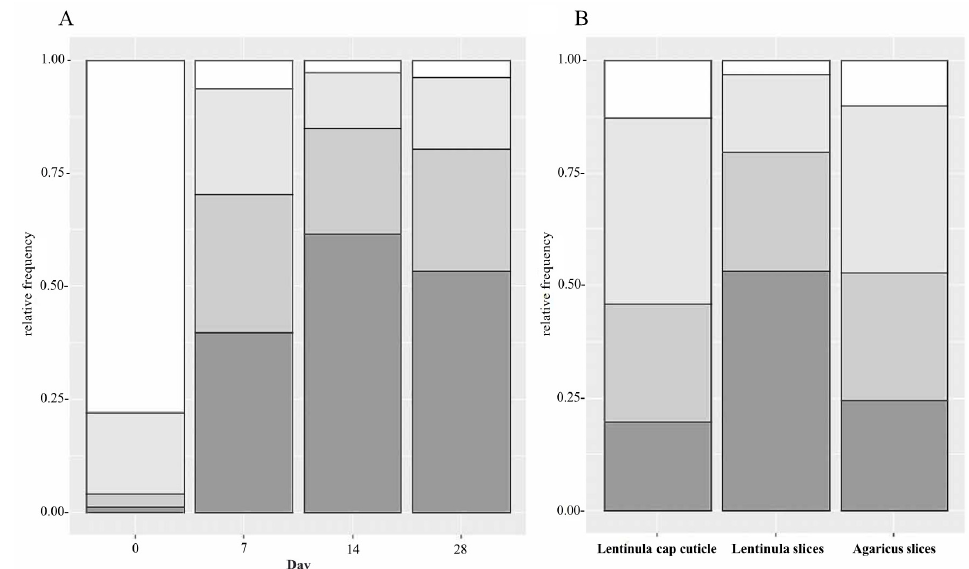
Figure 3. Predicted damage severity caused to L. edodes tissues by the microbial strains inoculated in the pathogenicity test, according to the day of storage in which the strains were isolated ( A ). Mean damage levels provoked by the inoculated microbial strains (all time points pooled) on L. edodes and